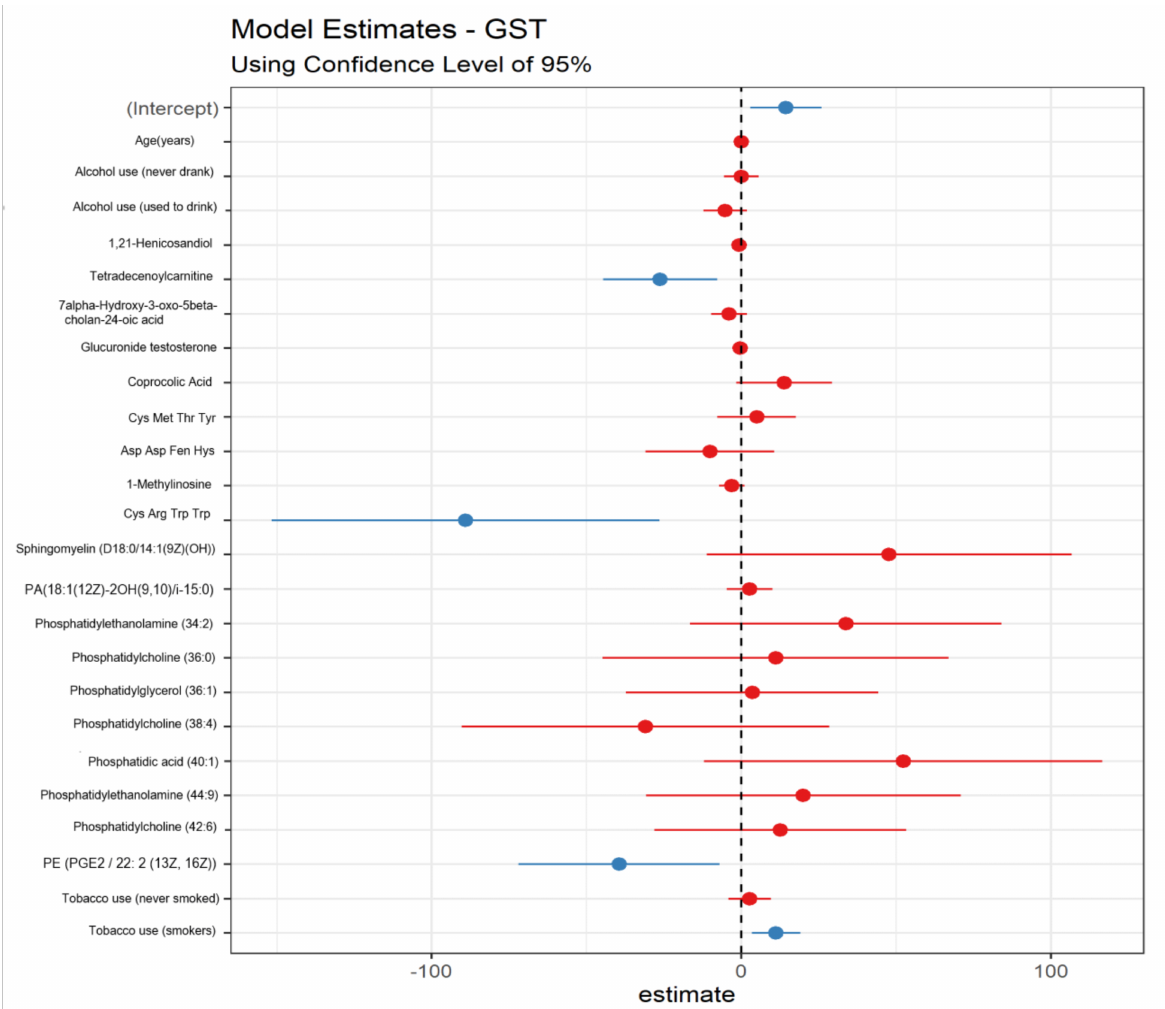
Figure 5. Multiple regression results and estimates of β 0 and β κ for the main metabolites and sociodemographic variables for the biomarkers MDA, thiol, CAT, and GST. Note: Coefficients calculated using linear regression, with a 95% confidence interval (CI). In blue, significant urinary metabolites and in red, non-significant urinary